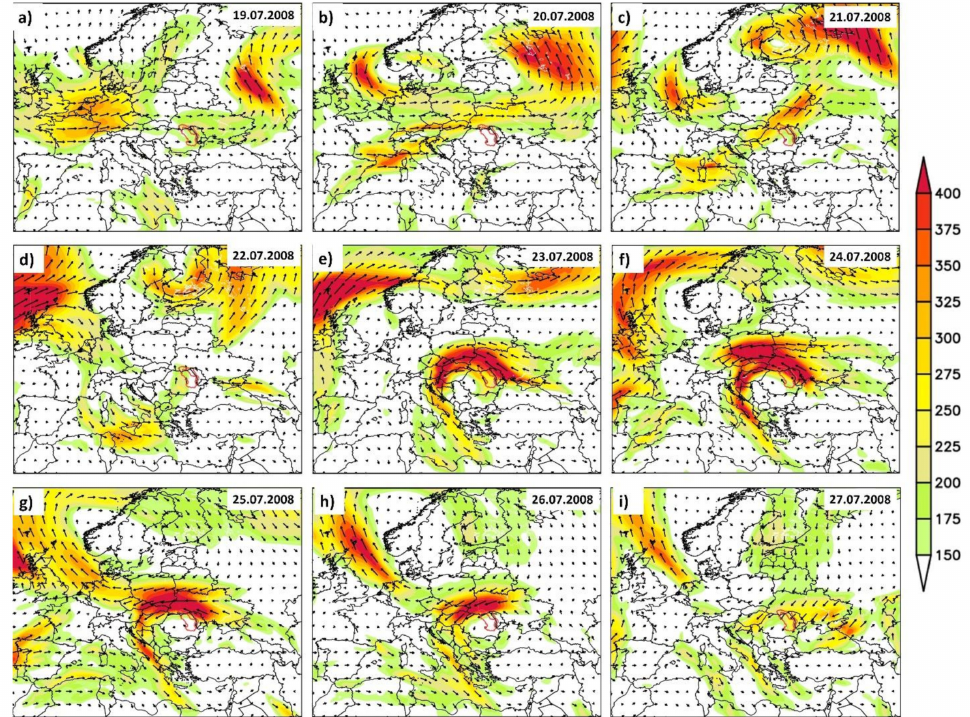
Figure 4. Magnitude (shaded colors) and direction (vectors) of the daily integrated water vapor transport (WVT) for: ( a ) 19 July 2008; ( b ) 20 July 2008; ( c ) 21 July 2008; ( d ) 22 July 2008; ( e ) 23 July 2008; ( f ) 24 July 2008; ( g ) 25 July 2008; ( h ) 26 July 2008, and ( i ) 27 July 2008. Units: WVT (kg · s − 1 · m − 1